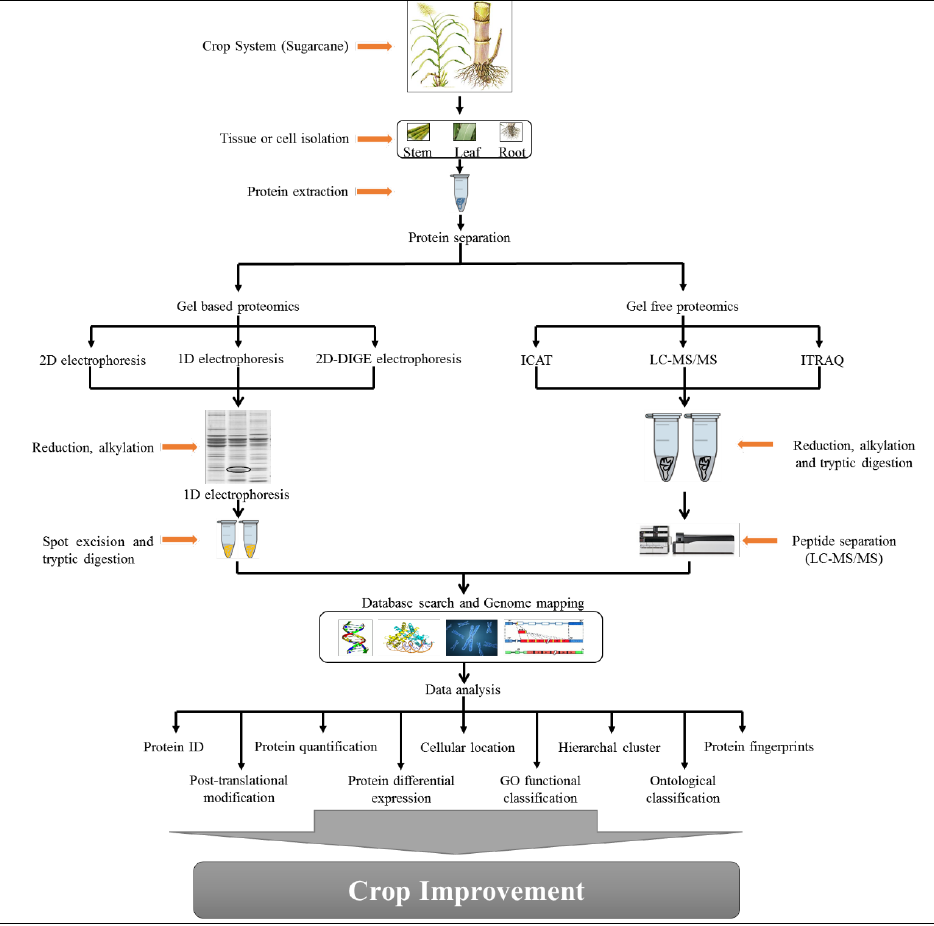
Figure 3. The workflow of sugarcane proteomics from crop system sampling using gel-based and gel-free proteomics